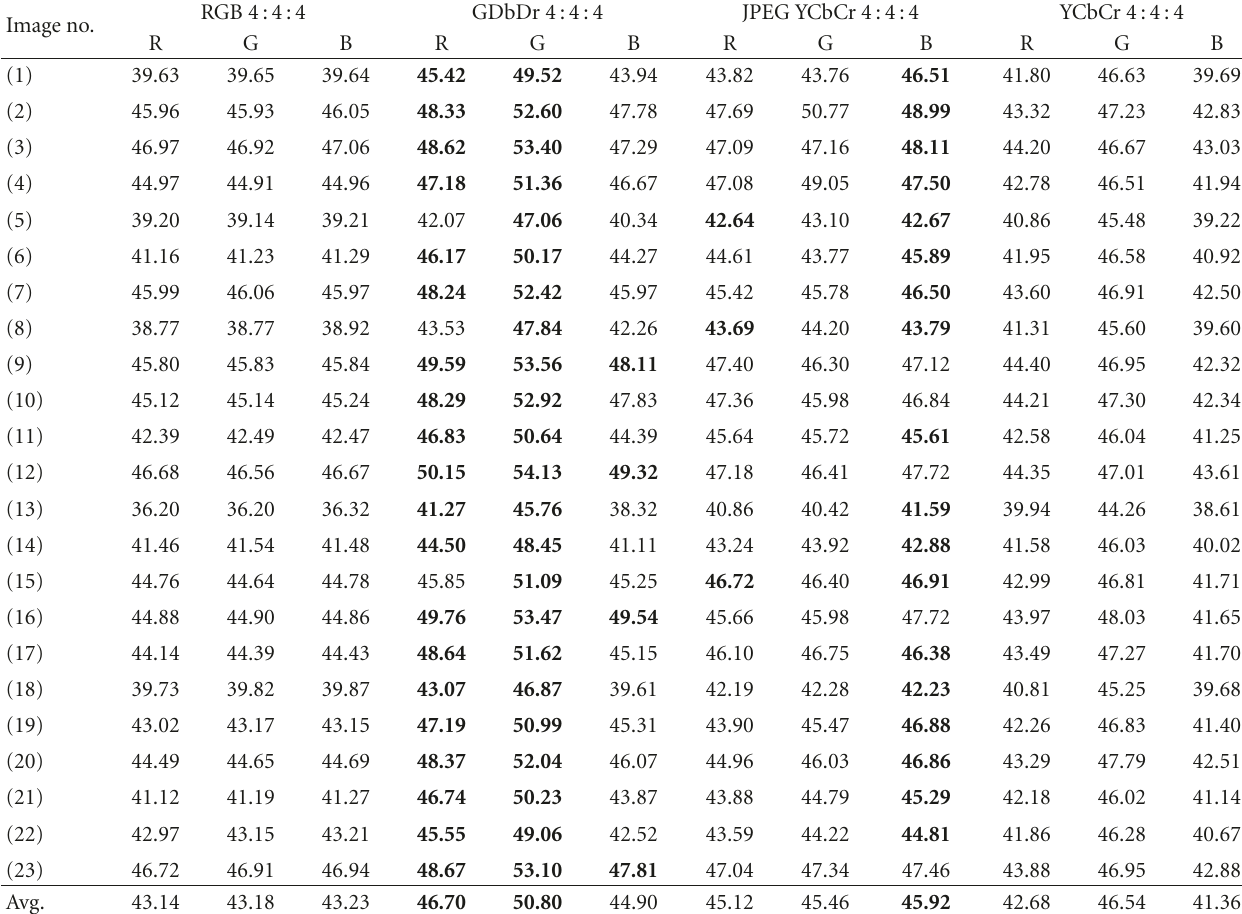
Table 6: PSNR (db) of frame memory compression for 23 Images with various color transformations. Image